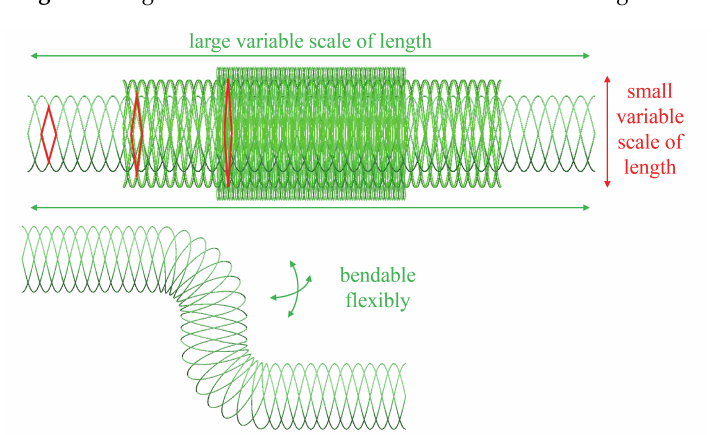
Figure 2. Degrees of freedom and restraints of a 2D-following chain.